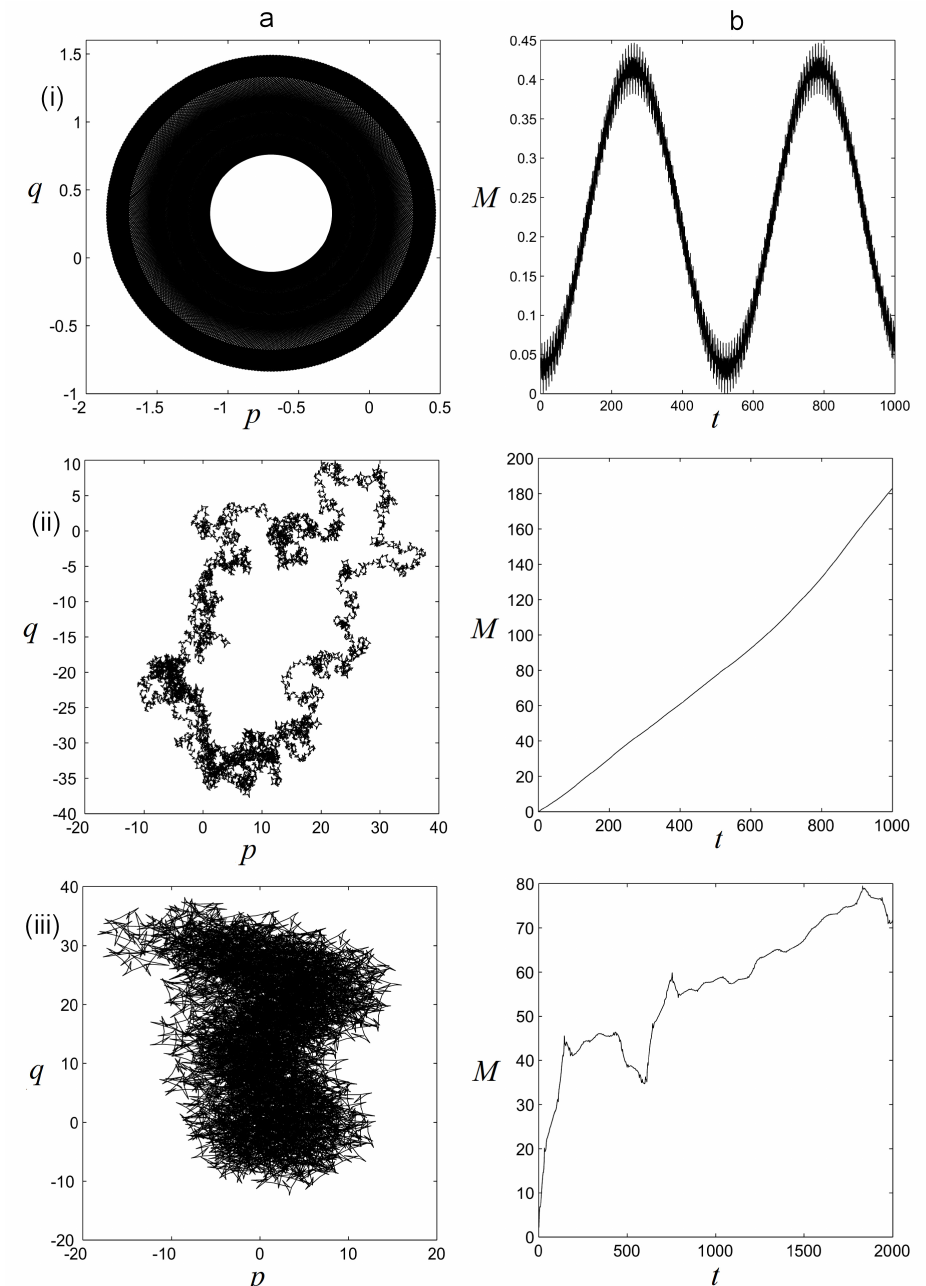
Figure A1. The elements of the ‘0-1‘ test; ( a ) presents the plots of q versus p and ( b ) presents the mean-square displacement M as a function of n . (i) represents the regular orbit of the logistic map x n + 1 = rx n ( 1 − x n ) for r = 3.55; (ii) presents the chaotic orbit of the logistic map for r = 4; (iii) presents an SNA of the GOPY map x n + 1 = 2 a tanh ( x n ) cos ( 2 πθ n ) , θ n + 1 = θ n + ω , with a = 1.5, √ and ω = ( 5 − 1 )